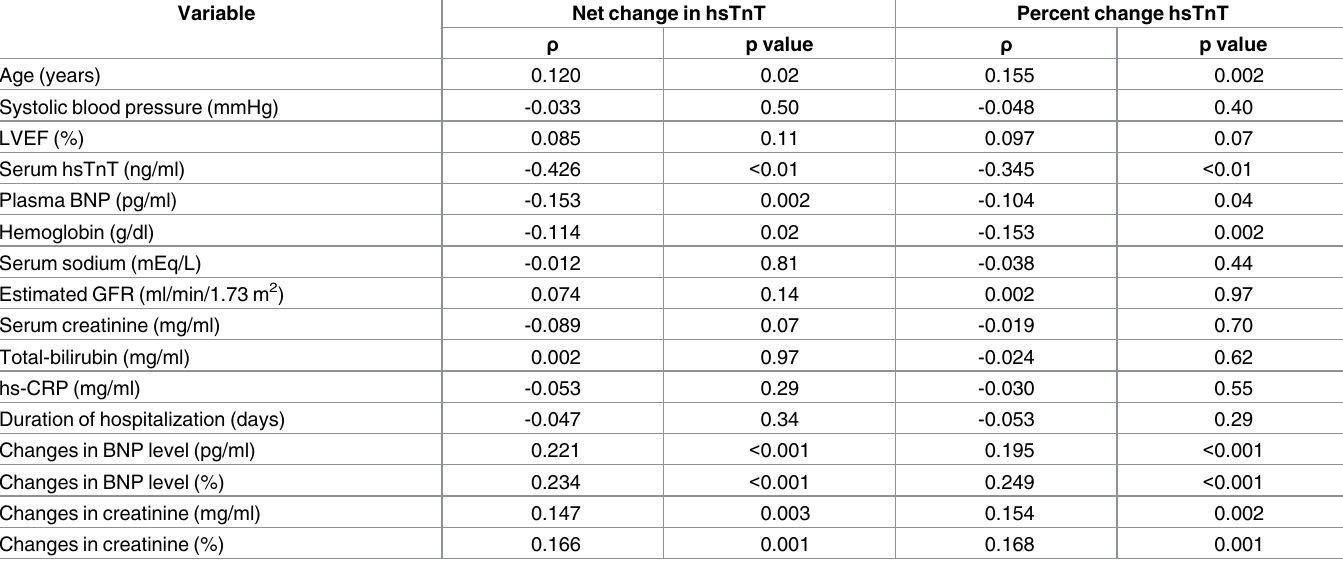
Table 2. Results of univariate linear regression analysis for changes in hsTnT